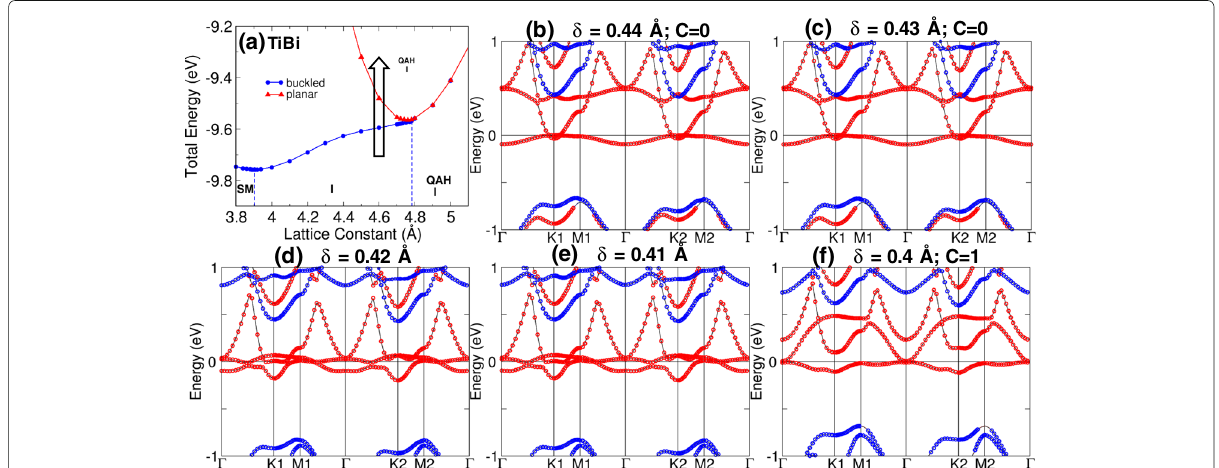
Fig. 3 Phase transition after varying the buckled distance. a Phase diagram of TiBi at a = 4.6 Å. The arrow shows the path of the transition. b – f The band structure transition as the buckling distance ( δ ) was reduced from 0.44 to 0.4 Å. The transition occurs at δ = 0.41 Å